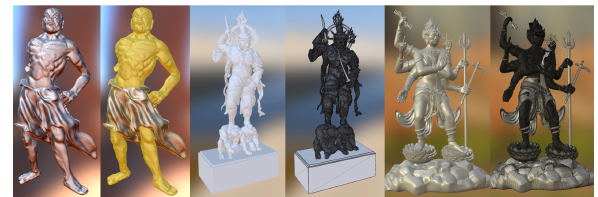
Figure 1. Deities at the temples of Kyoto and Nara sculpted by digital tools.